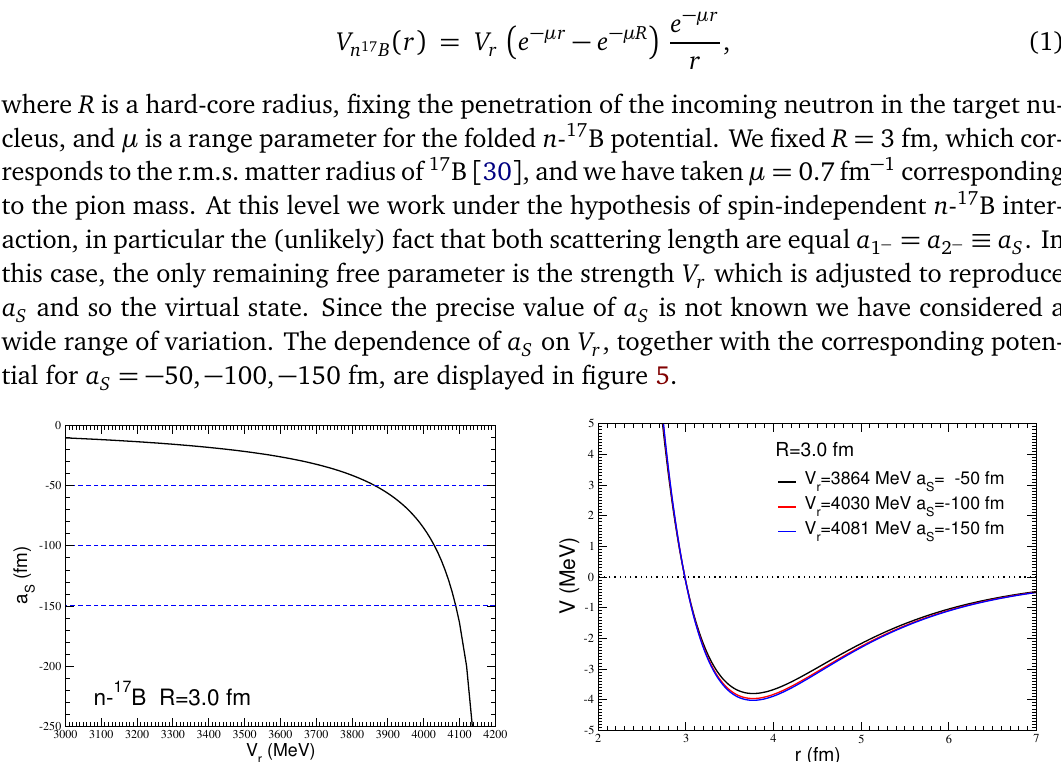
on V for R = 3 fm (left S r = -50,-100,-150 fm S (in MeV) for which V have been drawn r n 17 B